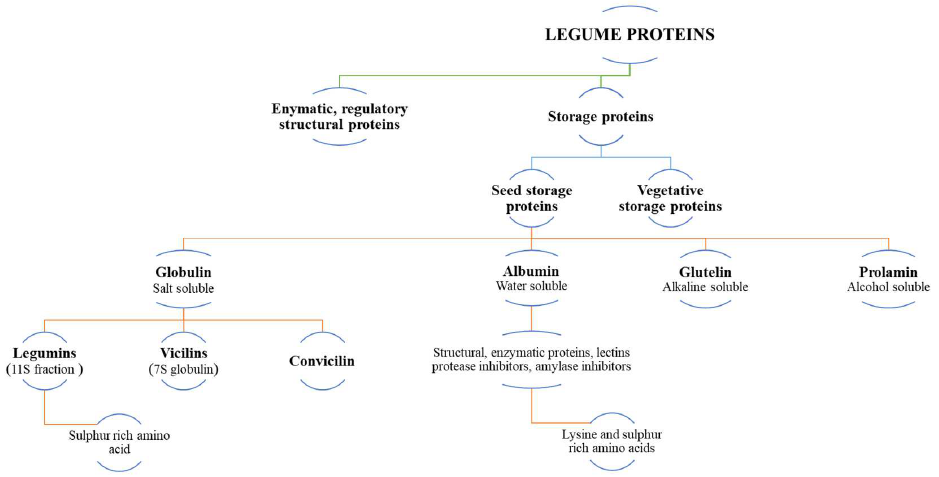
Figure 2. Classification of legume proteins [35–37,40–43].